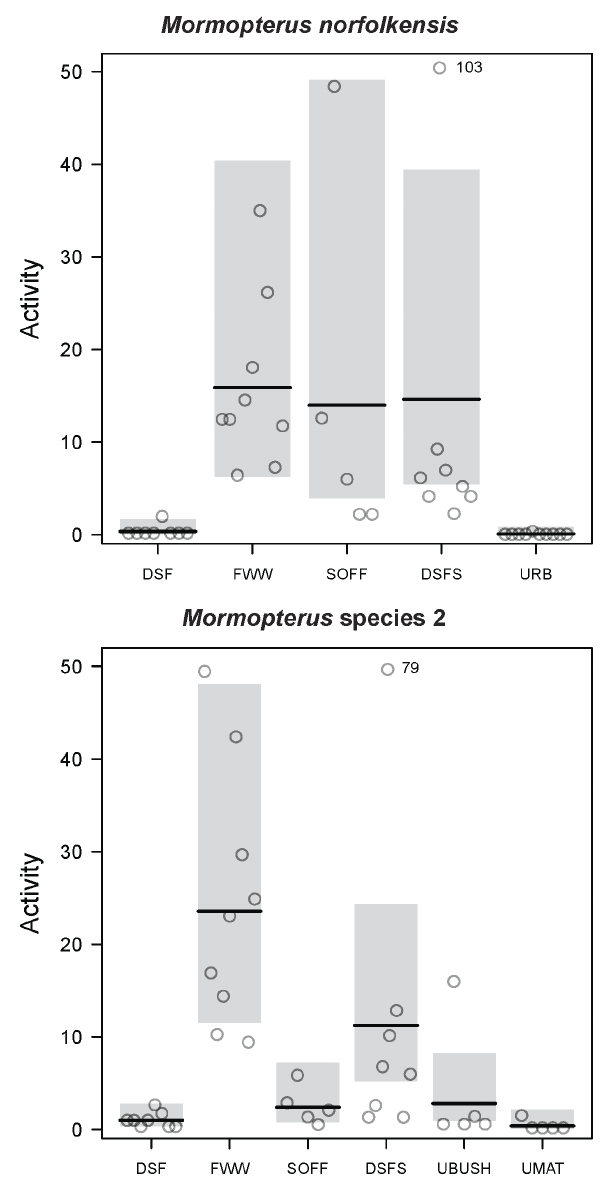
Figure 4. Habitat model response graphs. Partial conditional response graph of the relationship between the relative activity (number of passes) and habitat types included in the best-fitting negative binomial generalised linear models for Mormopterus norfolk- ensis and Mormopterus species 2. The grey shading represents 95% confidence intervals. Outliers are indicated by a number next to the point which specifies the value. FWW - freshwater wetland; DSF - dry sclerophyll forest and woodland; DSFS - dry sclerophyll forest and woodland on sand; UBUSH - urban bushland remnant; UMAT - urban matrix; URB - urban sites; MAN - mangrove forest; and SOFF - swamp oak forest.